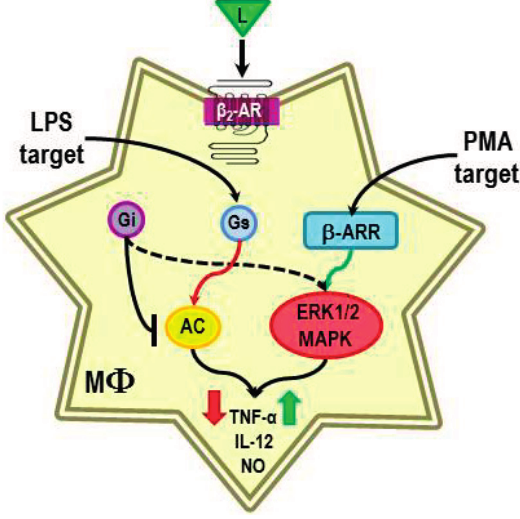
gene transcription to increase the production of TNF- α